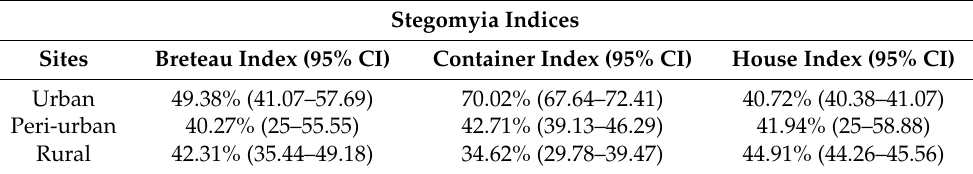
Table 5. Entomological Stegomyia indices in urban, peri-urban and rural settings. Stegomyia Indices Sites Breteau Index (95% CI) Container Index (95% CI) House Index (95% CI) Urban Peri-urban